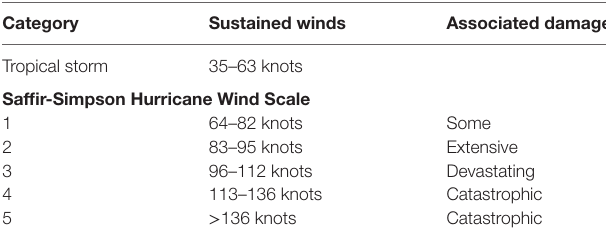
TaBle 1 | Tropical cyclone ranking system for the western